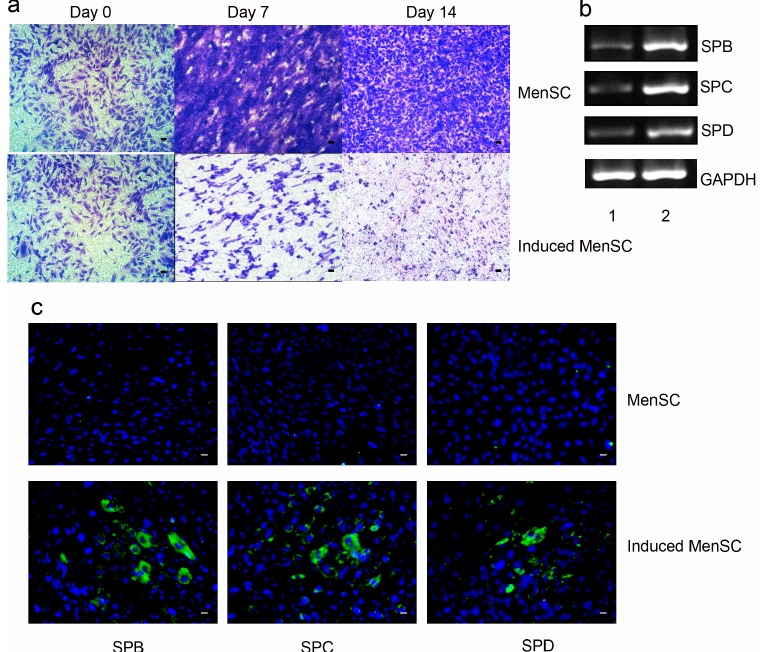
Figure 4. Differentiation of MenSCs into lung epithelial cells. ( a ) The shape of the cells had changed from spindle-like to polygonal-like, similar to that of lung epithelial cells; ( b ) After induction, MenSCs expressed SPB, SPC and SPD, markers of lung epithelial cells while the control group remains none; ( c ) RT-PCR confirmed the expression of MenSC markers before (lane 1) and after (2) induction; Scale bar: 50 µm.